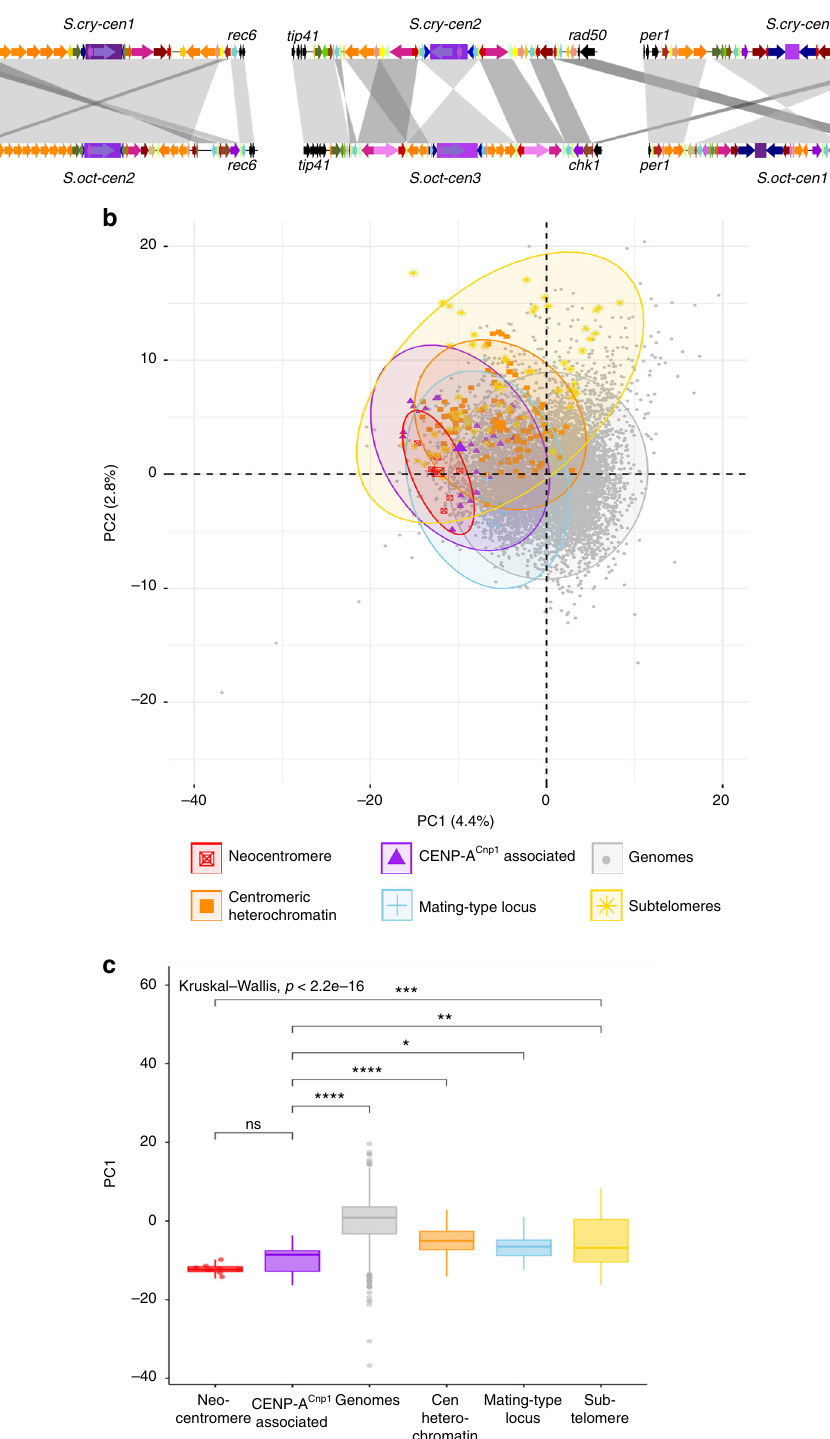
Fig. 4 Schizosaccharomyces centromeres share ancestry and sequence features. a Structural alignment of putatively equivalent centromere repeat elements of S. cryophilus and S. octosporus to highlight potential centromere rearrangements during evolution. b Principal component analysis PC1 and PC2 of 5-mer frequencies of three fi ssion yeast genomes. Genome regions (12 kb window) were assigned to one of fi ve speci fi c annotated groups (CENP-A Cnp1 - associated (purple, n = 24), centromeric heterochromatin (orange, n = 112), mating-type locus (blue, n = 18), subtelomeres (yellow, n = 67), neocentromere-forming regions 34 (red, n = 9), or other genome regions (grey, n = 7652). For each group the oval line encloses 95% of the data points. c Boxplot principal component PC1 of each group. Colours and values for n as in b . Mean comparison between groups was used ( p -value: > 0.05, ns; * p > 0.01; ** p > 0.001; *** p > 0.0001; **** p < 0.0001) 66 . Centre line, medium; box limits, upper and lower quartiles; whiskers, 1.5 × interquartile range; points, outliers. Source data available: GEO: